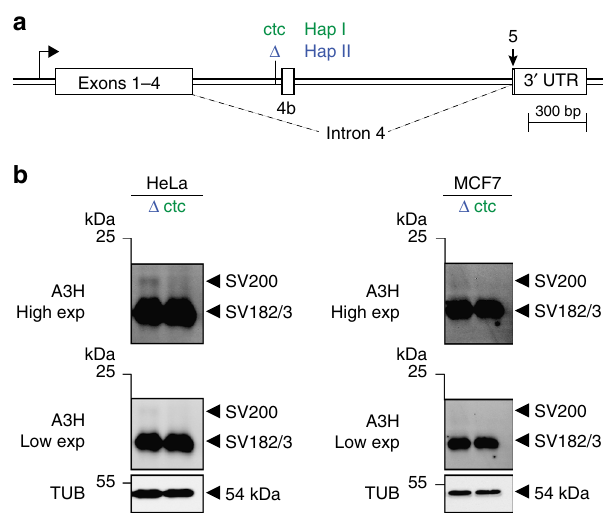
Fig. 4 In fl uence of non-coding intron 4 ctc versus Δ ctc on A3H minigene expression. a Schematic of the A3H minigene construct with key elements labeled. The minigene haplotype I intron has ctc (green) and the haplotype II intron has Δ ctc (blue). These constructs are otherwise identical. b Immunoblots of HeLa and MCF7 whole-cell extracts expressing the indicated A3H minigene constructs (representative of two independent experiments). Low and high exposures are provided to show that SV200 expression is speci fi c to the haplotype II minigene. An anti-TUBULIN (TUB) blot is shown as a loading